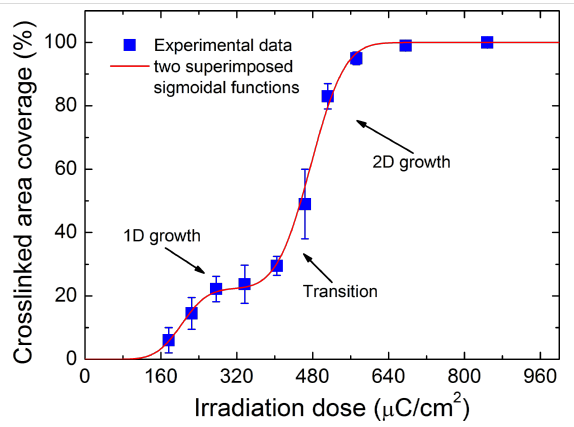
Figure 4: Percentage of the cross-linked area plotted as a function of the irradiation dose: (1) no CNM forms below the threshold dose of approximately 160 µC/cm 2 ; (2) the formation of nuclei occurs up to a surface coverage of 6–10%; (3) the 1D growth dominates for a coverage of up to about 35% and the required mean dose is approxi- mately 200 µC/cm 2 ; (4) the 2D growth dominates for a coverage above about 35% and the required mean dose is approximately 480 µC/cm 2